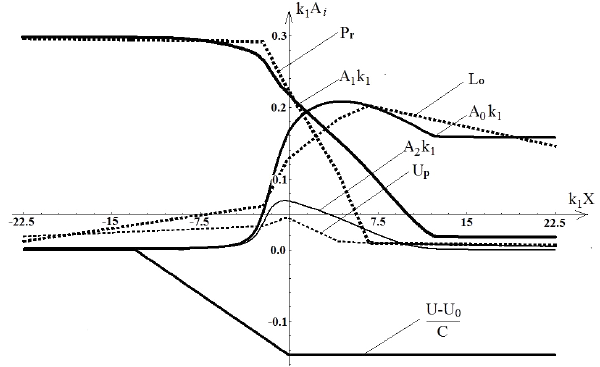
Figure 4. Dashed curves show the amplitudes of the waves for pri- mary (Pr), lower (Lo) and upper (Up) sidebands obtained experi- mentally by Chavla and Kirby (2002). The solid lines ( A 1 ,A 0 ,A 2 ) are wave amplitudes calculated in modeling. (U − U 0 )/C is the no-dimensional variable current, where C is the initial phase speed of the carrier wave, U 0 = − 0 . 32 m/s ; k 1 = 4 . 71 /m,C = 1 . 44 m/s,T = 1 . 2 s .